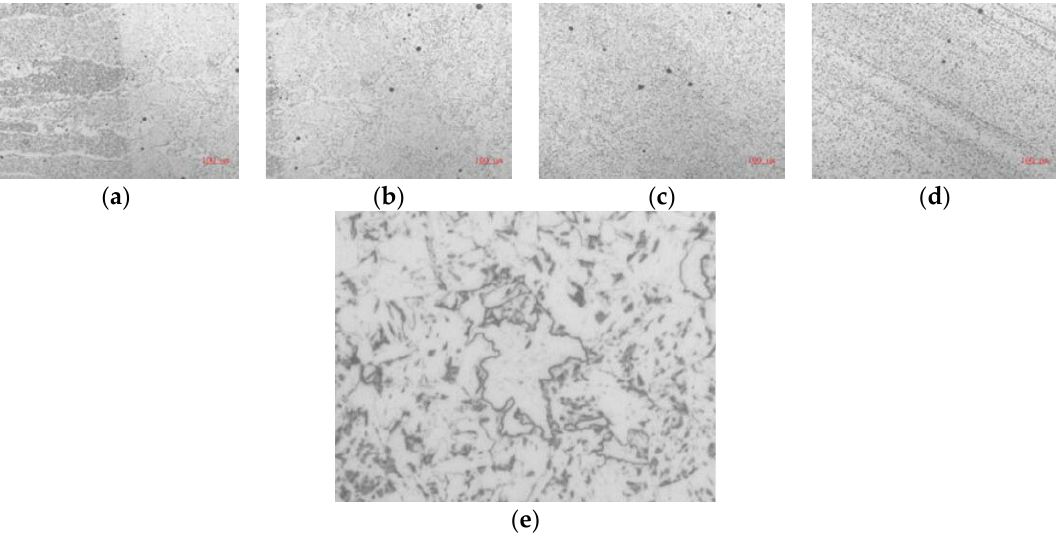
Figure 7. Metallographic structure of HAZ for 25 mm thickness: ( a ), the metallographic structure of welding fusion zone; ( b , c ), the metallographic structure of welding heat affected zone; ( d ), the metallographic structure of the steel plate; ( e ), the higher magnification image of partial area of Figure 7b.